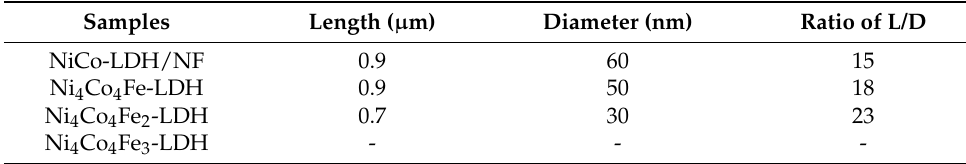
Table 1. The parameters of the